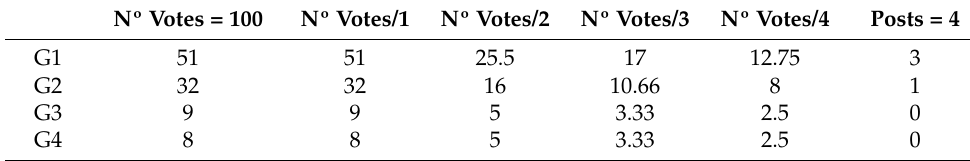
Table 6. D’Hondt rule allocation table—example with four groups and 100